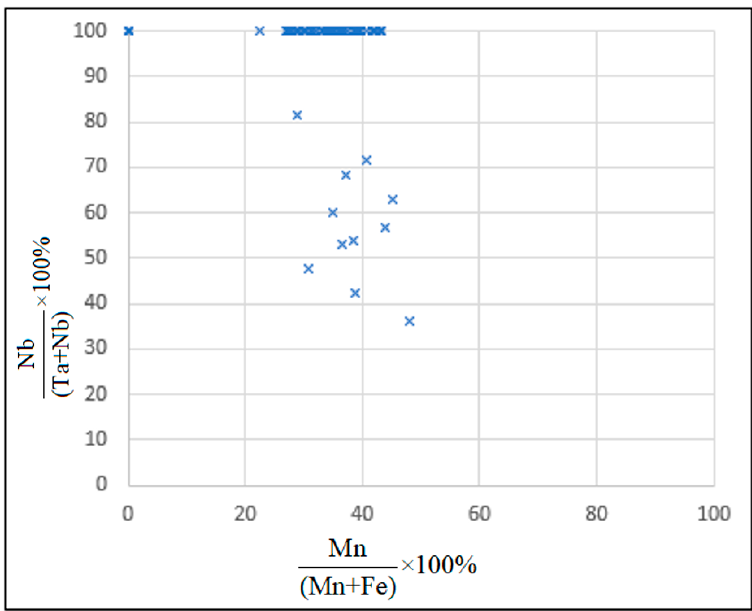
Figure 5. Proportion of the Fe, Mn, Nb, and Ta ions of the measured crystals.